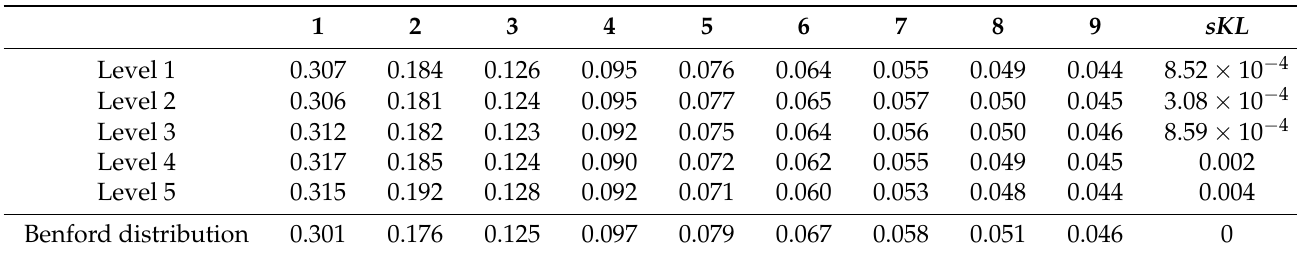
Table 2. Average first digit distribution (FDD) of singular values in the KADID-10k [46] database with respect to the five different distortion levels of KADID-10k. Level 1 stands for the lowest level of distortion, while Level 5 denotes the highest distortion. The column sKL indicates the symmetric Kullback–Leibler divergence between the actual FDD and the prediction of Benford’s